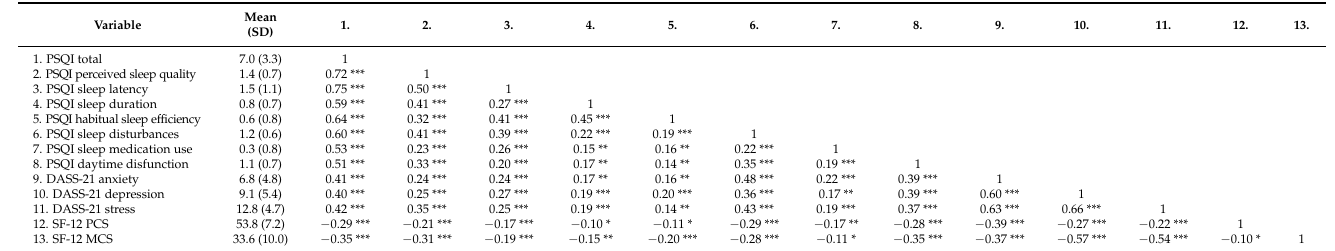
Table 2. Pearson’s correlation coefficients between sleep quality components (as measured by the PSQI), anxiety, depression, stress (measured by the DASS-21), and physical (SF-12 PCS) and mental (SF-12 MCS) health-related quality of